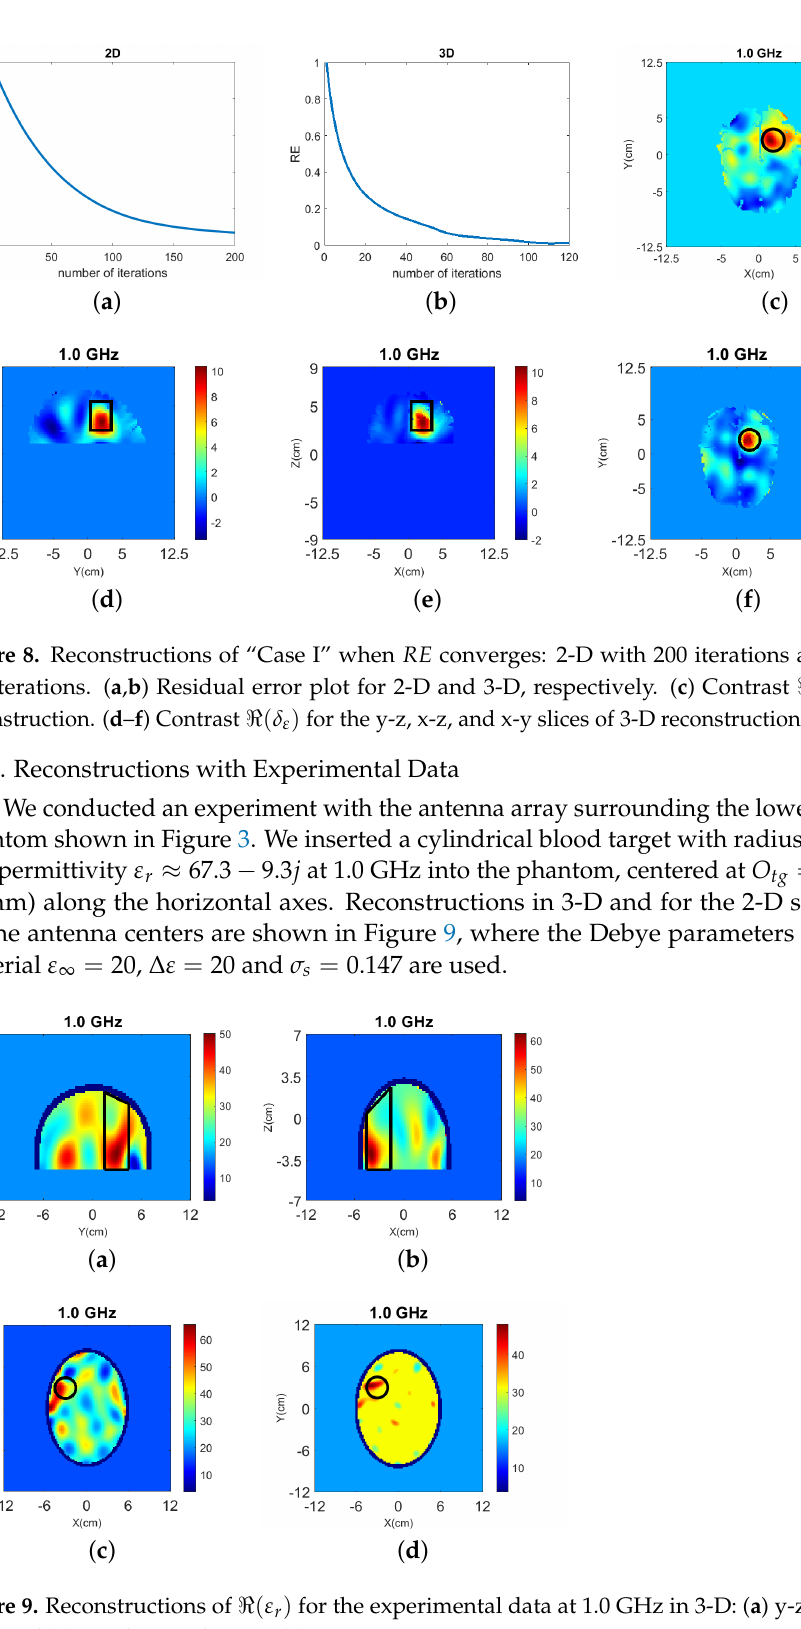
Figure 9. Reconstructions of (cid:60) ( ε r ) for the experimental data at 1.0 GHz in 3-D: ( a ) y-z slice, ( b ) x-z slice, and ( c ) x-y slice, and in 2-D ( d